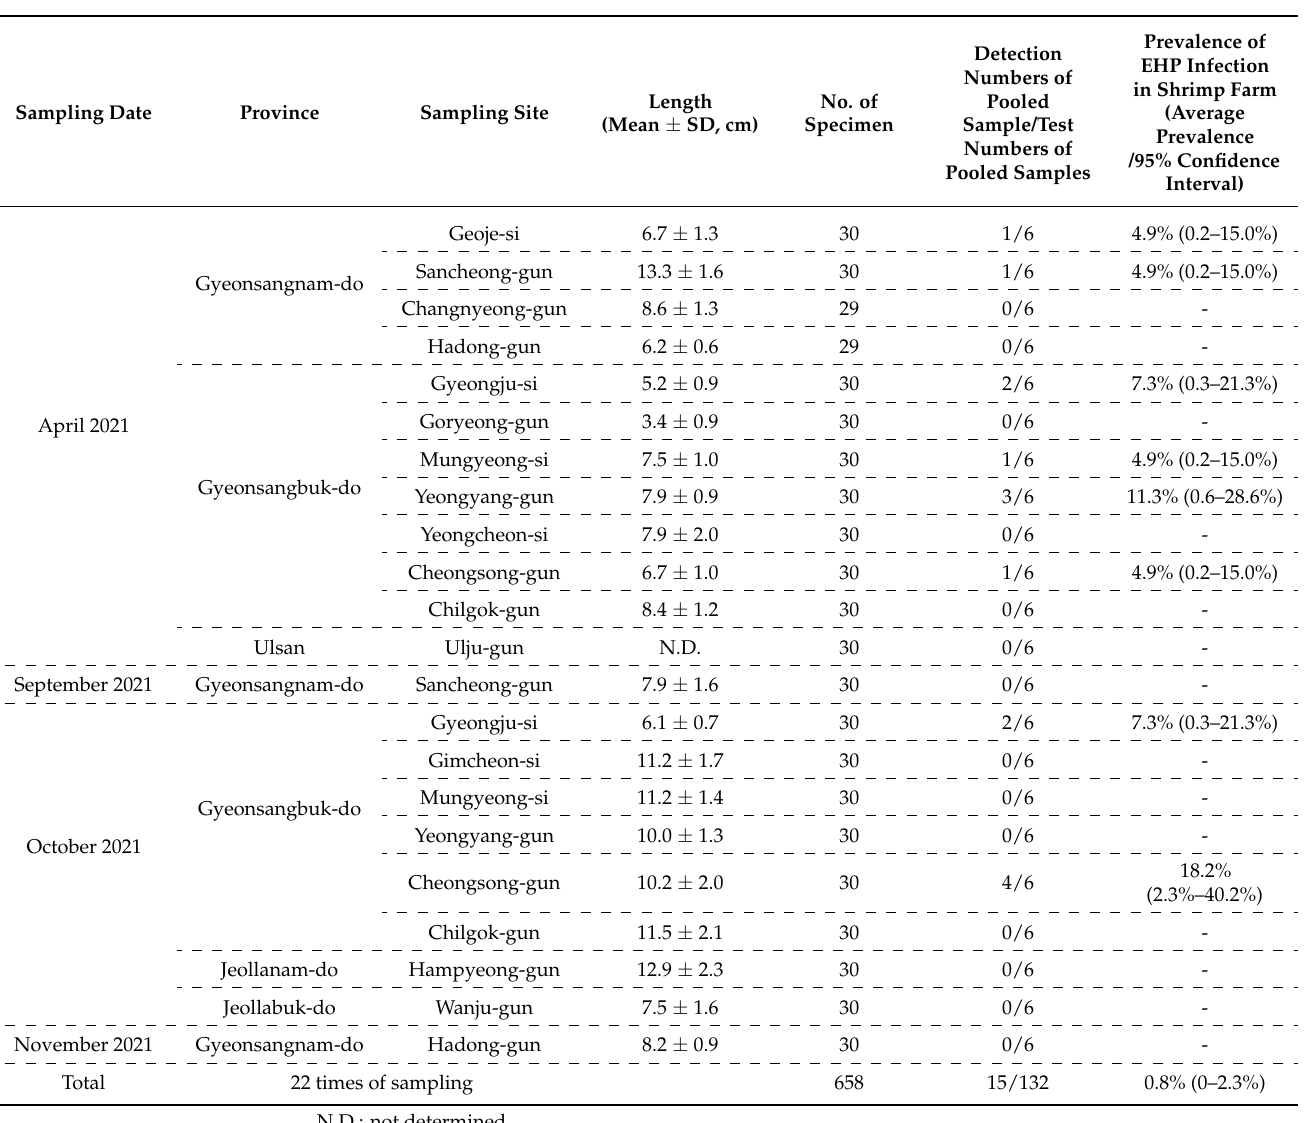
Table 1. Prevalence estimation of EHP infection with PCR test results of giant freshwater